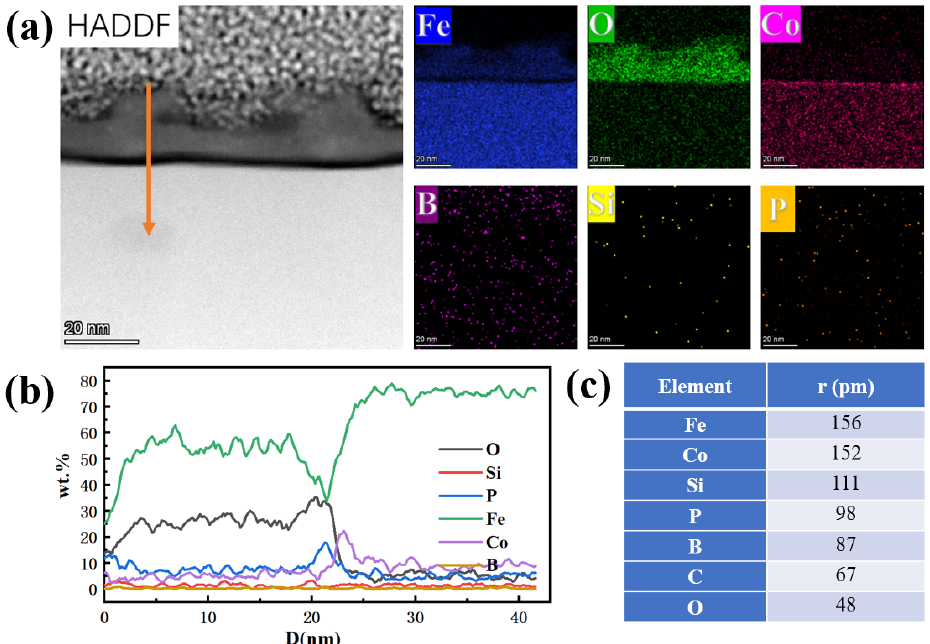
Figure 10. ( a ) TEM image of the surface after pre-oxidation at 280 °C for 60 min; ( b ) results of EDS line scan; ( c ) atomic radius of each element. line scan; ( c ) atomic radius of each